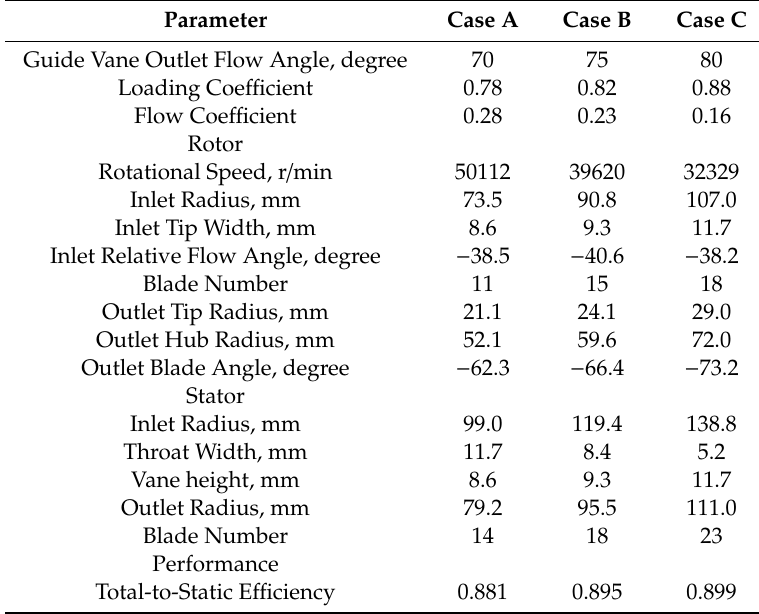
Table 4. The preliminary design results of the radial turbines for the case